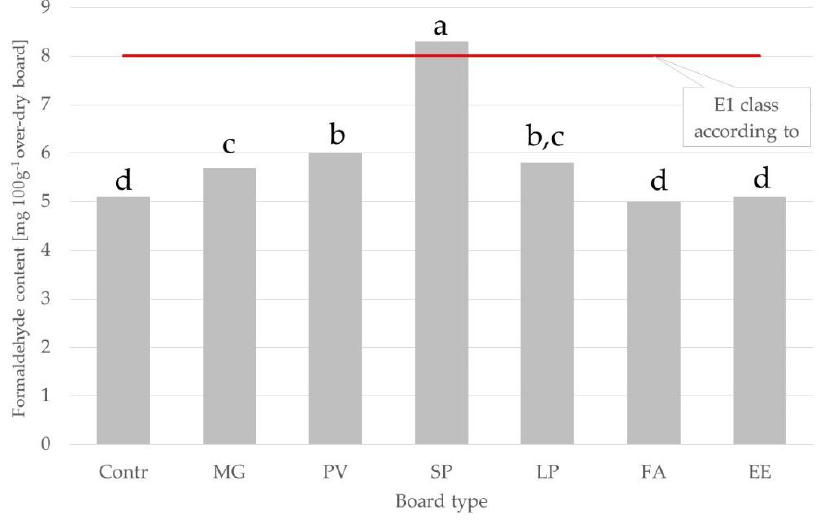
Figure 9. Formaldehyde content in tested particle boards made with the addition of biomass from different grass species. Abbreviations used: contr. — control (100% wood); FA — Festuca arundinacea , different grass species. Abbreviations used: contr.—control (100% wood); FA— Festuca arundinacea